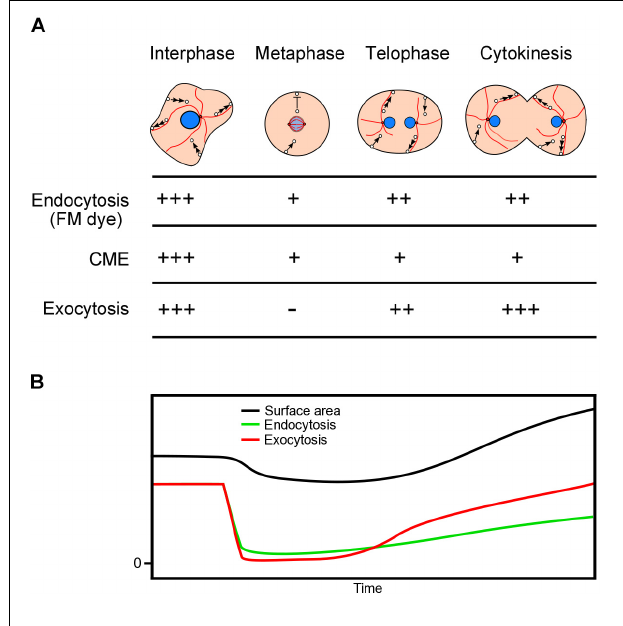
FIGURE 5 | Dynamics of cell membrane surface area during cell division. (A) Summary of the dynamics of microtubules, endocytosis, and exocytosis during cell division. In the interphase cells, endocytosis, and exocytosis are balanced to maintain a constant total cell surface area. When the cells enter the prophase, astral microtubules disappear, resulting in the suppression of exocytosis. Exocytosis recovers as astral microtubules reappear during the telophase. Endocytosis is suppressed from the prophase to the metaphase and recovers by half during cytokinesis. CME is suppressed from the prophase to cytokinesis. (B) Time course of estimated endocytosis and exocytosis and the relative total cell surface